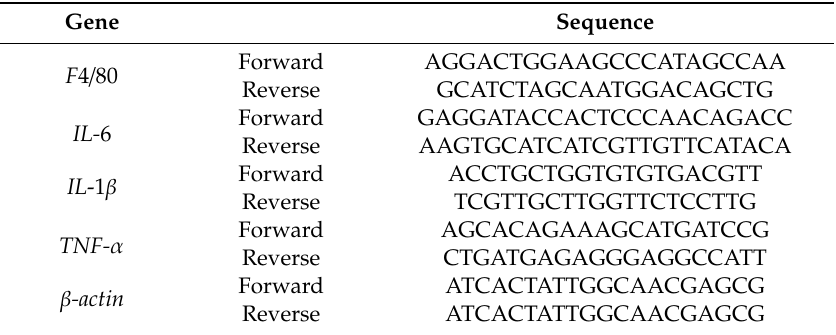
Table 2. List of primer sequences for qRT-PCR.